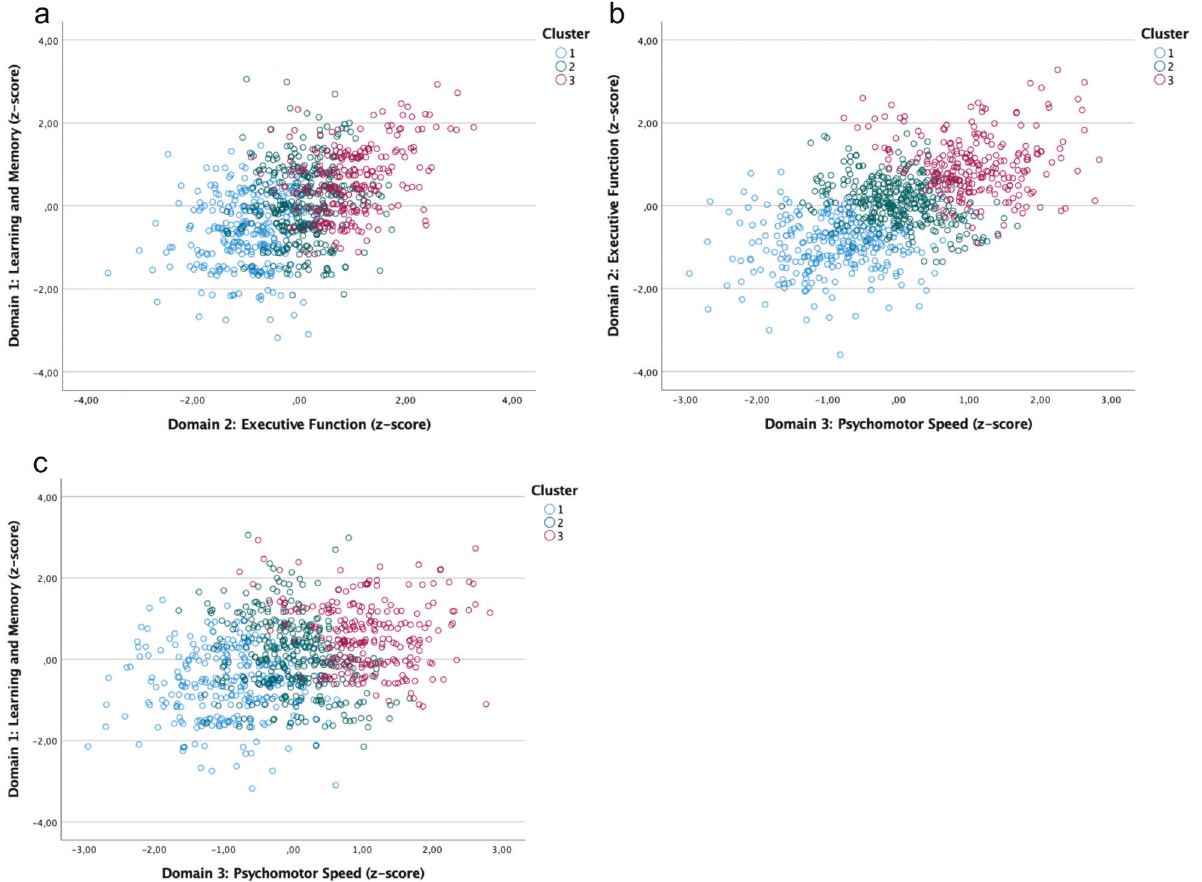
Fig. 1 Cross-diagnostic clusters of cognitive performance. Scatter plots showing the distribution, with color-coded cluster designations, of the following cognitive domains: a learning and memory and executive function, b executive function and psychomotor speed, and c learning and memory and psychomotor